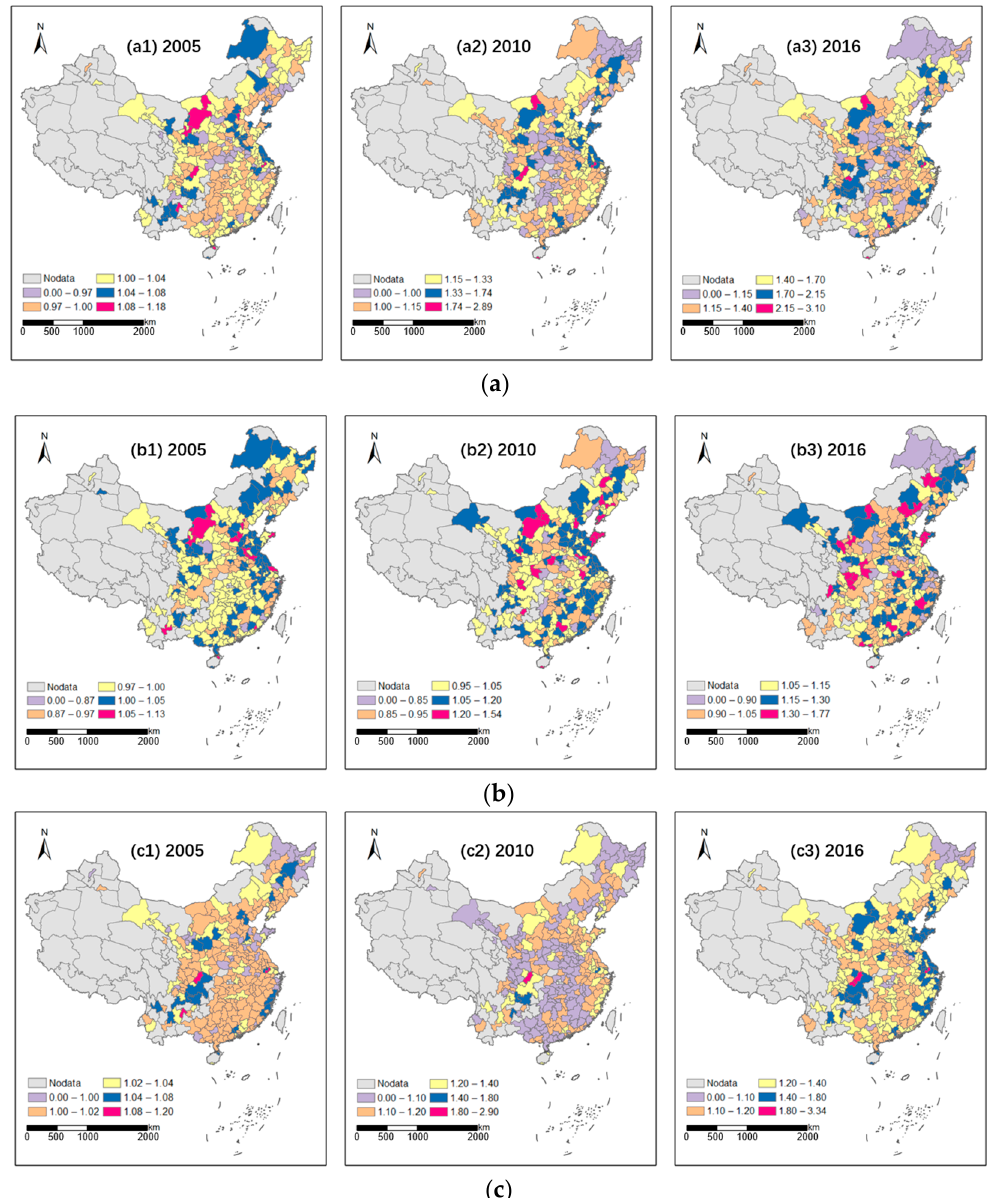
Figure 2. ( a ). Spatial distribution of GTFP scores of Chinese cities in 2005, 2010, and 2016. ( b ). Spatial distribution of EC scores of Chinese cities in 2005, 2010, and 2016. ( c ). Spatial distribution of TC scores of Chinese cities in 2005, 2010, and 2016.